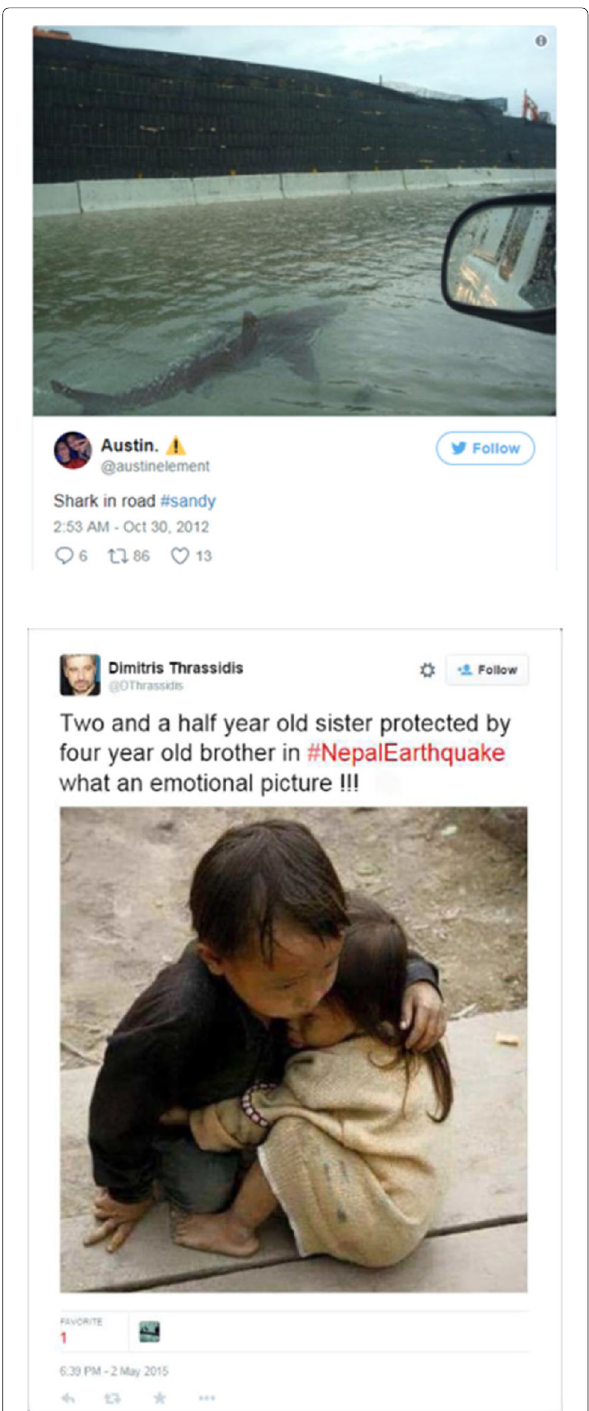
Fig. 5 Examples of composite objects containing misleading content. Top: forged image shared online in relation to the Hurricane Sandy in 2012 [51]. Bottom: pictures of vietnamese siblings, erroneously posted in relation to the earthquake in Nepal in 2015